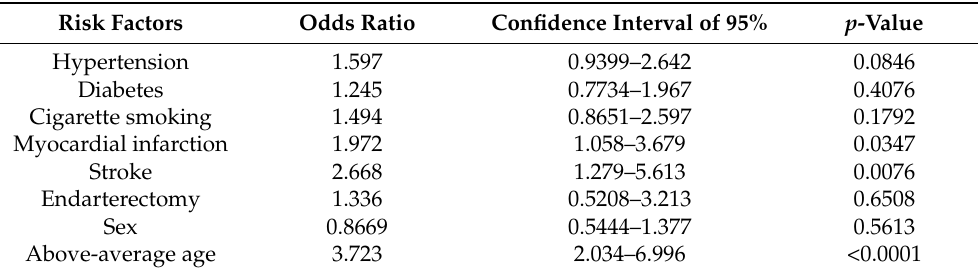
Table 8. Analysis of the correlations between the risk factors and worsening of stenosis in dyslipi- daemic patients (worsened patients: 165; stable patients: 133; and total patients: 298). Risk Factors